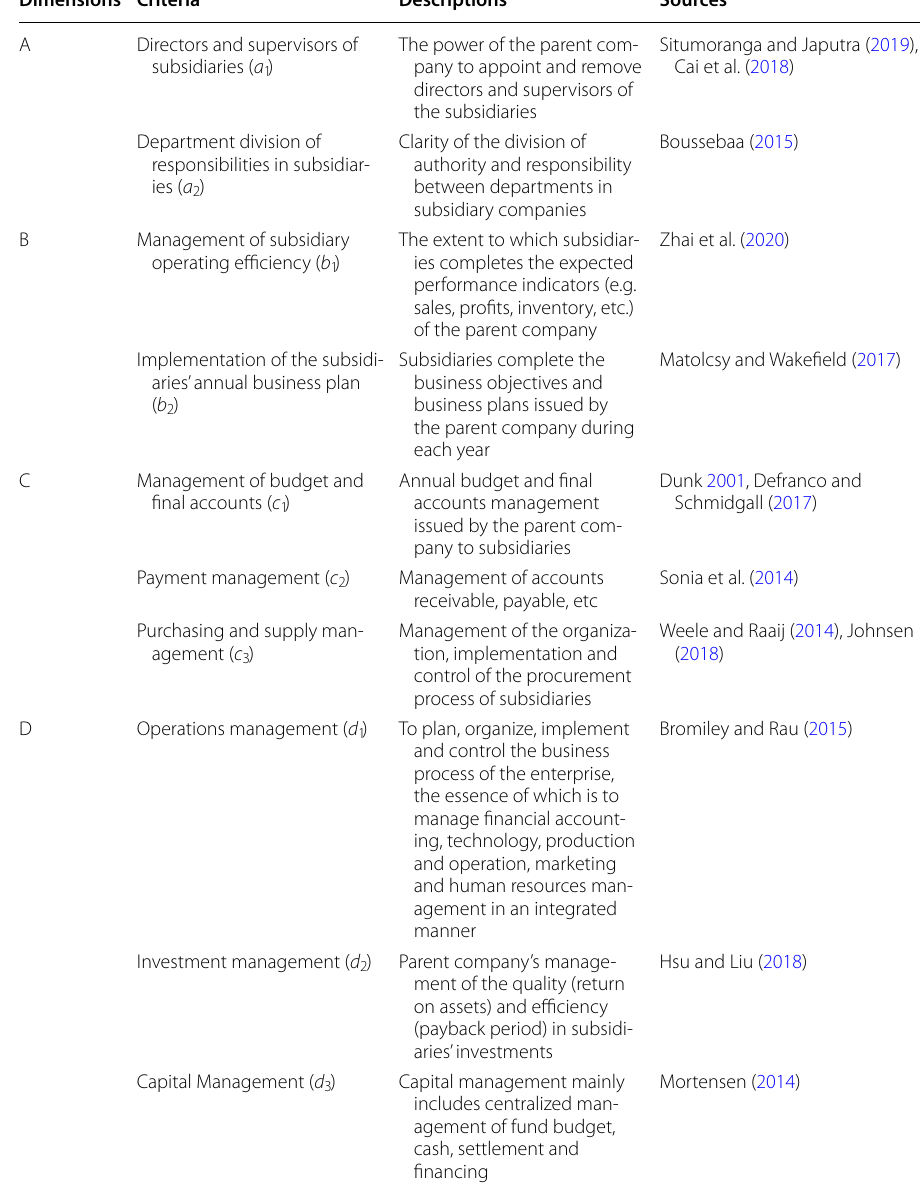
Table 4 Supervision and management of subsidiaries factor (criterion) assessment